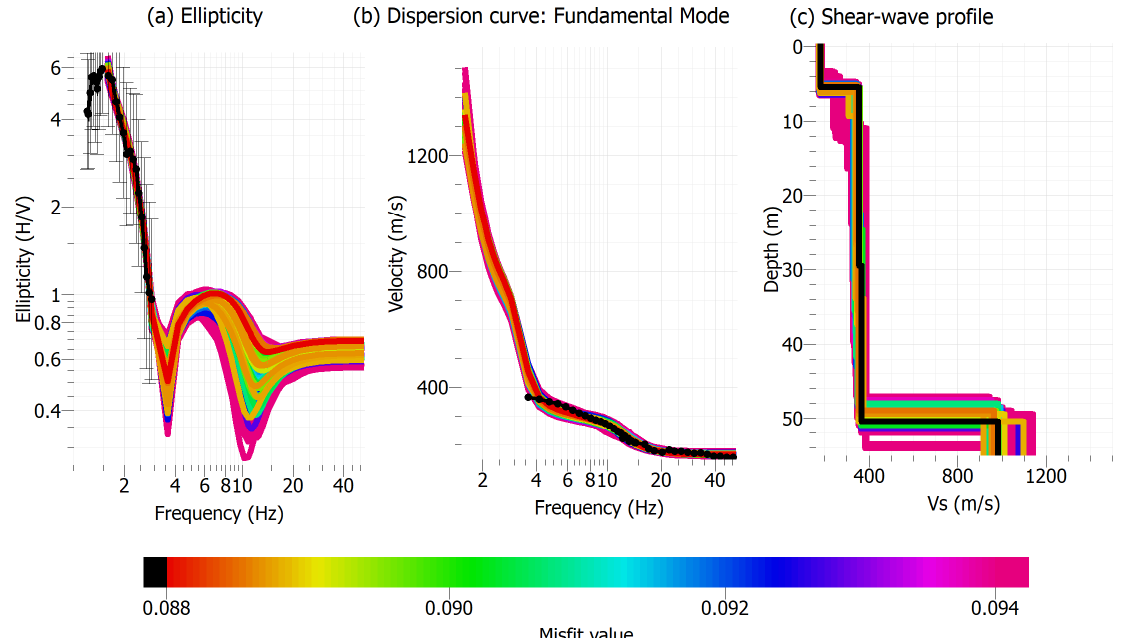
Figure 13. Inversion results in a point in the northern fine soils in Santiago using ellipticity of the Rayleigh waves from the H/V curve. ( a ) adjustment of the ellipticity curve between the observed curve (black line) and the best models. ( b ) adjustment of the dispersion curve between the observed curve (black line) and the best models. ( c ) models obtained from the inversion. Black line corresponds to the best model.